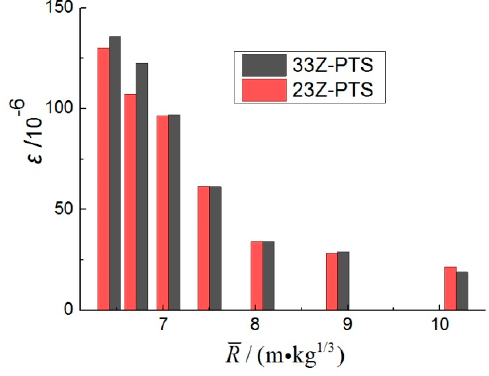
Figure 7. PTS of 23Z and 33Z ( R = 3.75 m).